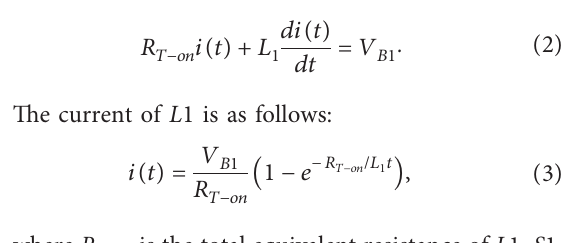
Figure 5: Signal waveform of inductors (L)1 and